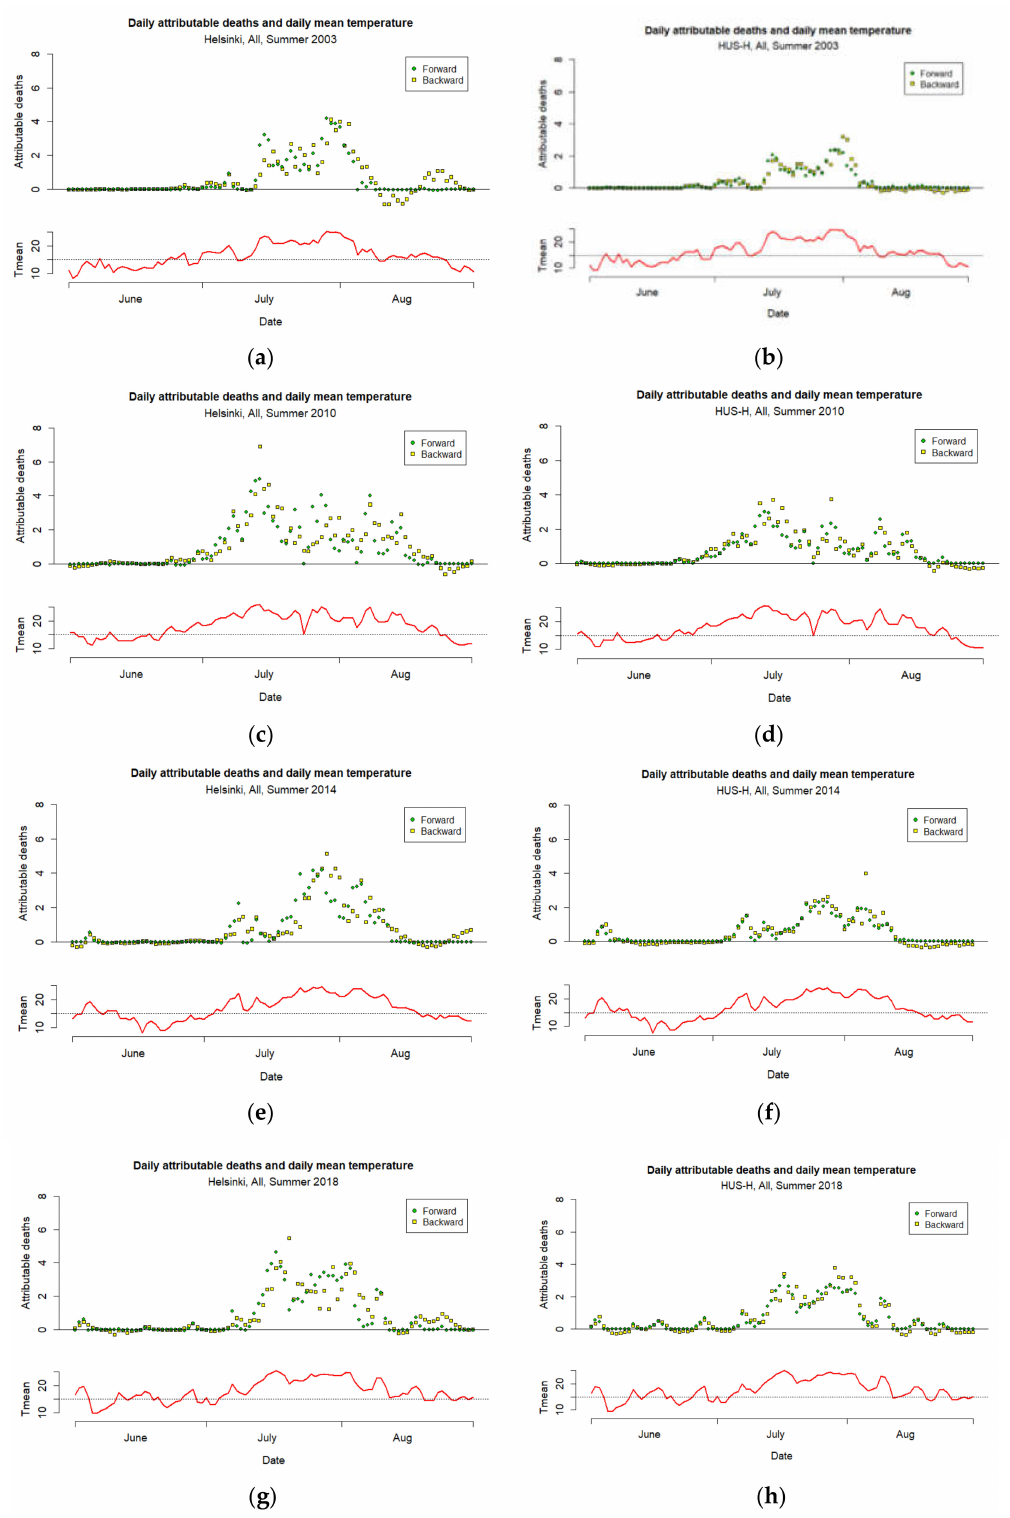
Figure 4. Daily deaths attributable to heat in summers 2003, 2010, 2014 and 2018 and daily mean temperature in Helsinki ( a , c , e , g ) and Helsinki-Uusimaa hospital district without Helsinki HUS-H, ( b , d , f , h ). These estimates were based on the modelled temperature–mortality relationships during 2000–2018, in which the impact of heat on mortality risk lasted for a few days. “Forward” refers to the prediction of the number of deaths based on the temperatures, and “backward” to the perspective in which the number of deaths was explained by the temperatures of the previous few